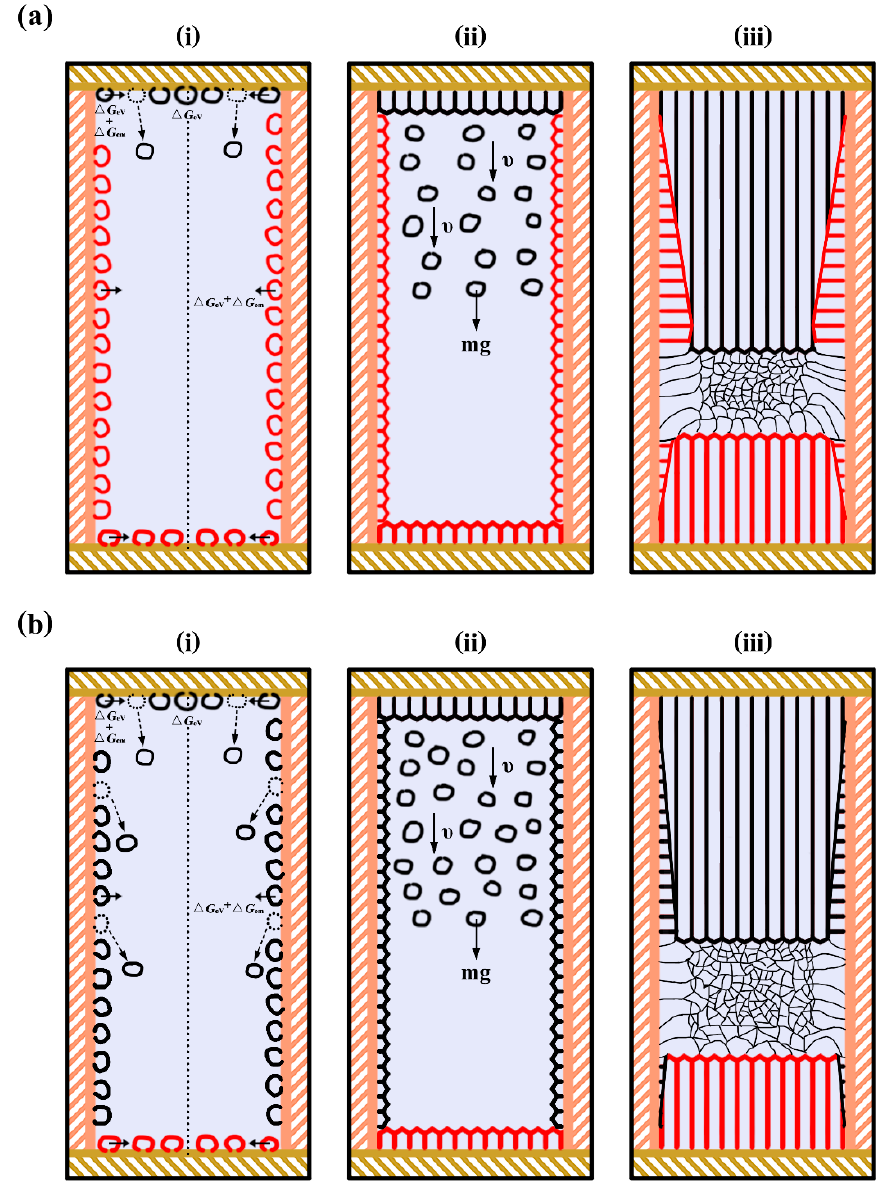
Figure 11. Schematic illustration of the formation process of FEG observed in the present study. The solidification proceeds from ( i ) to ( iii ). ( a ) under electropulsing with 480 A and ( b ) under electropulsing with 900 A.